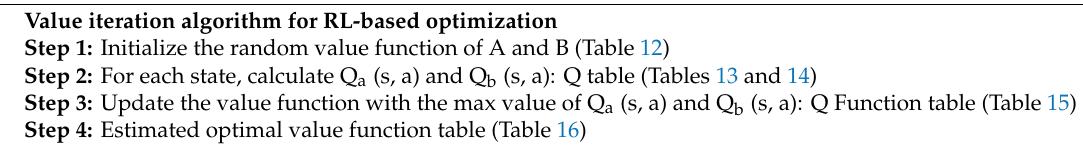
Figure 12. Value iteration algorithm with the Bellman equation for RL-based BEMS optimization by MDP.